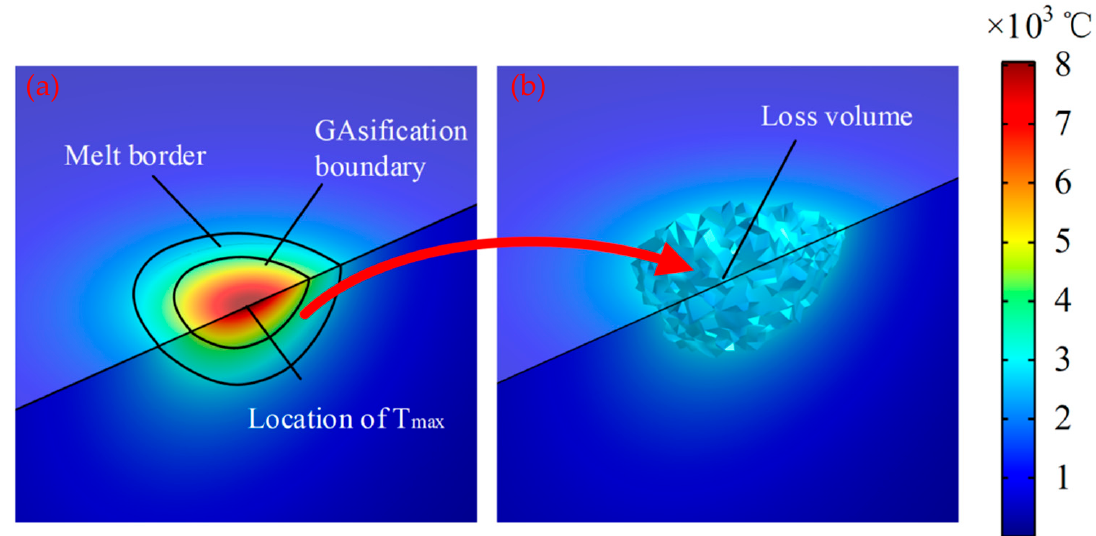
Figure 9. ( a ) Melting area of the micro-bit; ( b ) edm wear of the